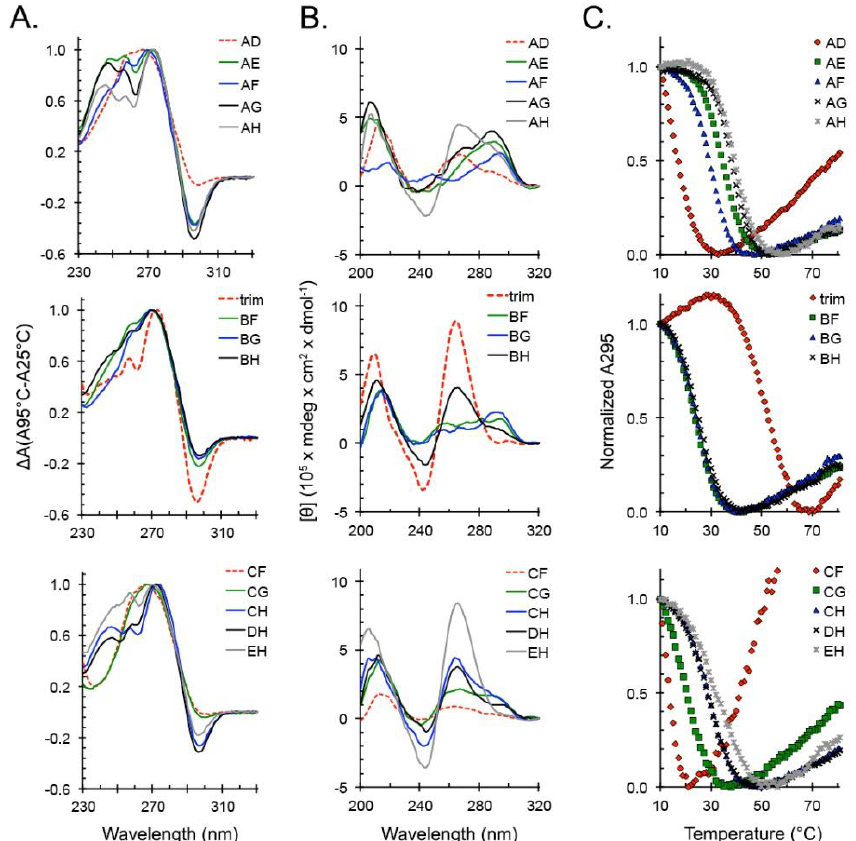
Figure 7. Spectroscopic analysis of a G-quadruplex (G4) formation by trim_A5U-locked variants.